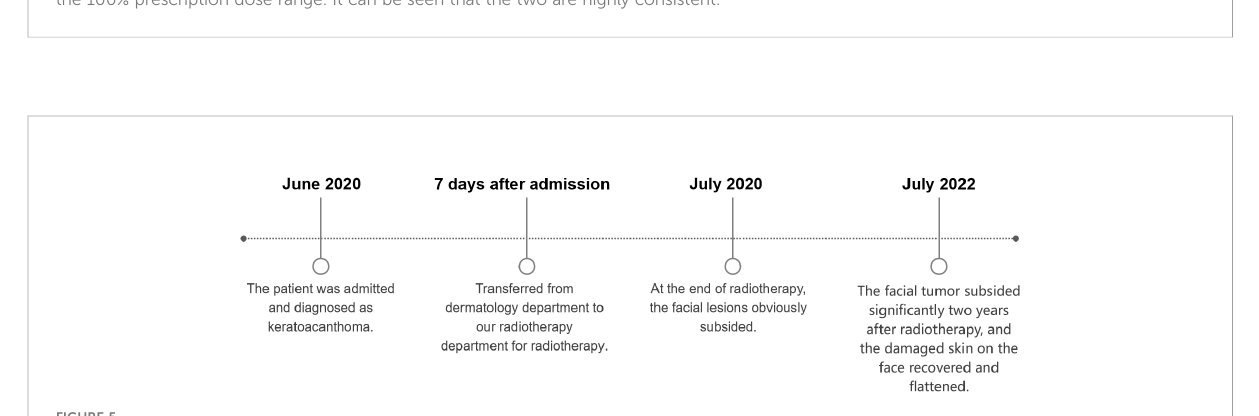
FIGURE 5 Some important time points for the treatment and follow-up of the patient after